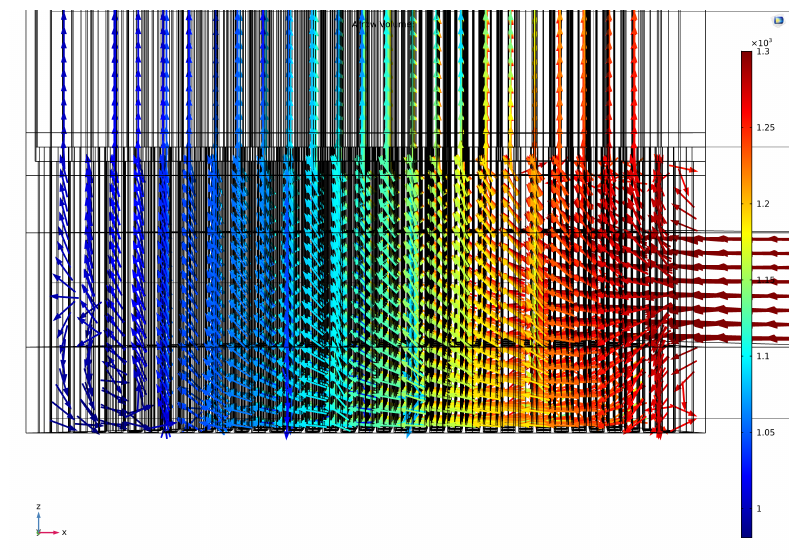
Figure 12. Velocity vector field of the molten salt with color indicating its